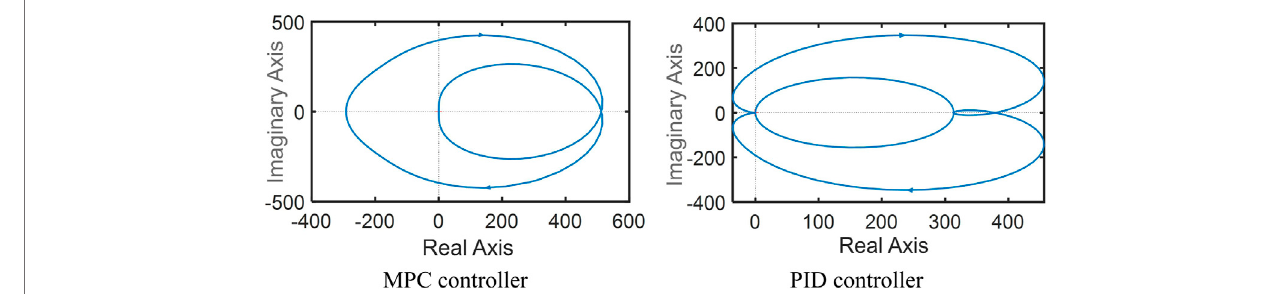
FIGURE 6 | Nyquist diagram of the core power control system.